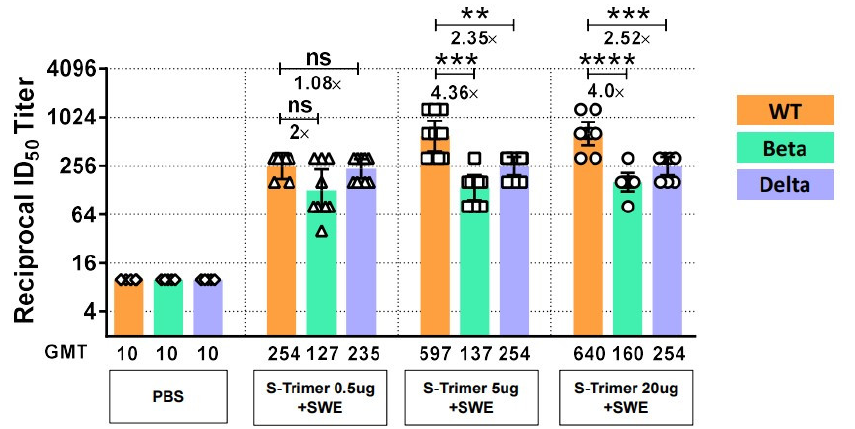
Figure 8. Cross-neutralization of SARS-CoV-2 variants by serum from S-Trimer with SWE vaccinated hamsters. Syrian hamsters ( n = 6–10/group) were administered PBS as a control or 0.5 μg or 5 μg or 20 μg of S-Trimer protein (wild-type) with SWE adjuvant via intramuscular injection twice on Day 0 and 28. Cross-neutralizing antibodies against SARS-CoV-2 variants, B1.1351 (Beta) and B1.1617 (Delta), were assessed by TCID50 assay at two weeks after the second vaccination. Symbols represent the reciprocal 50% inhibitory dilution ID 50 titer from an individual animal; bars represent the geometric mean ± 95% CI ID 50 titer. Statistically significant differences were compared by two-tailed Mann–Whitney test. ** p < 0.008, *** p < 0.0005, **** p < 0.0001; ns: not significant.